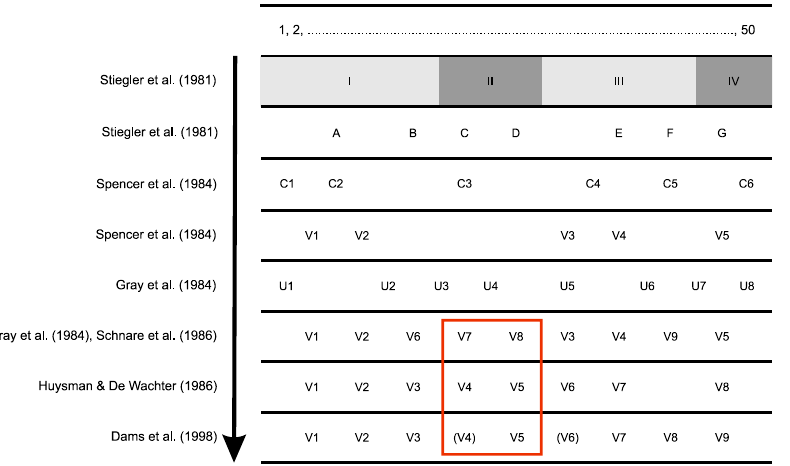
Figure 1. Changes in the small subunit rDNA numbering system throughout the years. The first line shows the helix numbering. Stiegler et al. [4] defined four domains (I–IV) and seven variable regions (A–G). Spencer et al. [5] defined five variable regions (V1–V5) of 18S rDNA that lie between the conserved regions (C1–C6). When V6–V9 were added [6–8], V6–V8 came to lie between V2 and V3 and V9 between V4 and V5. V1–V9 regions lie between the universal regions U1–U8 [6]. Huysmans and de Wachter [10] numbered the variable regions V1–V8 consecutively. Dams et al. [11] added the variable region V9. V4 is missing in prokaryotes, and V6 is absent in eukaryotes. Maia Da Silva et al. [27] claimed to use V7/V8, which corresponds to V4 according to the new numbering system.